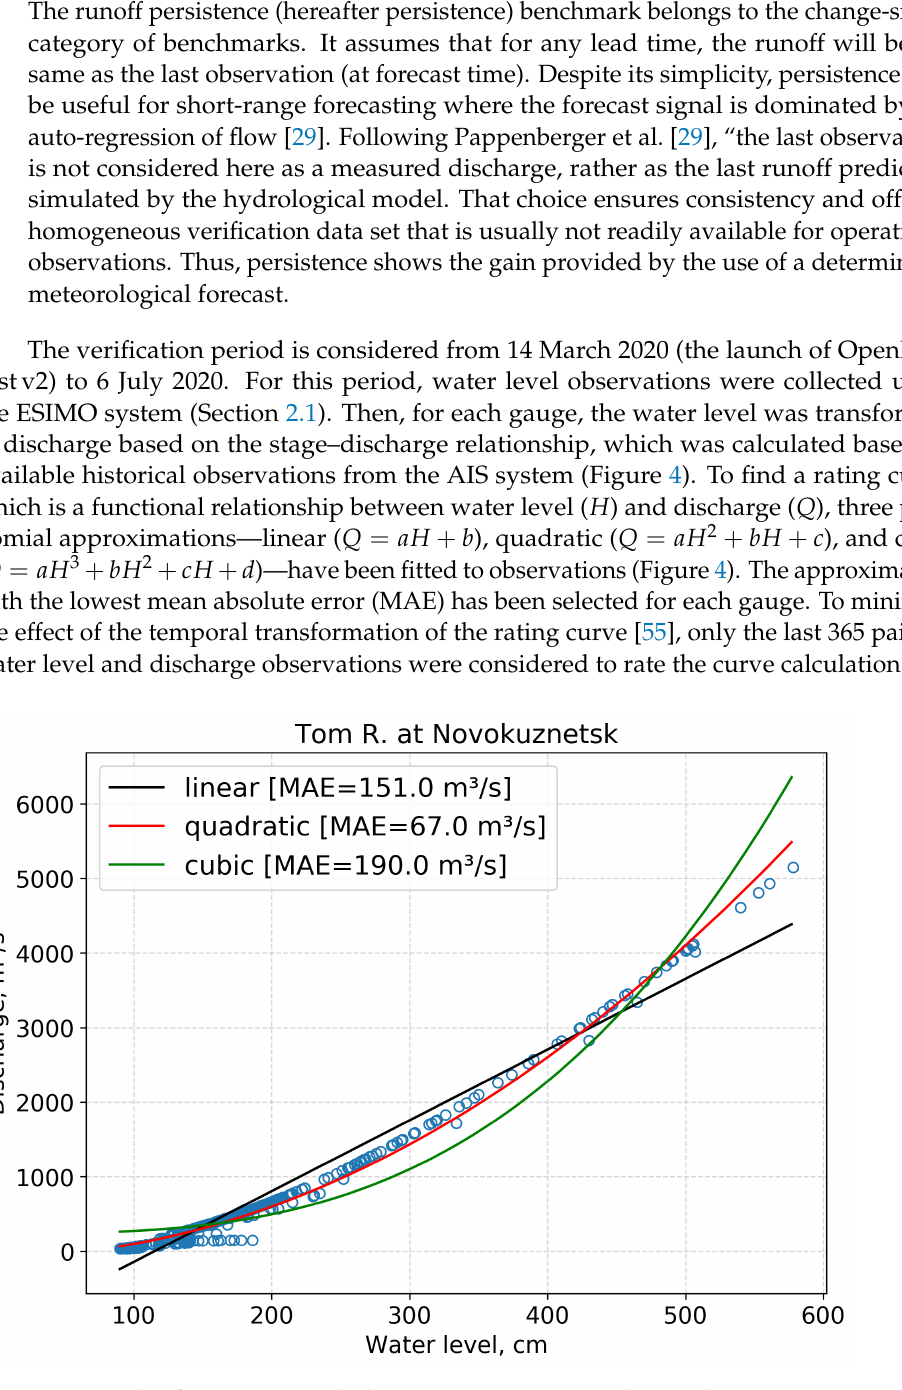
Figure 4. Example of rating curve calculation (Tom River at